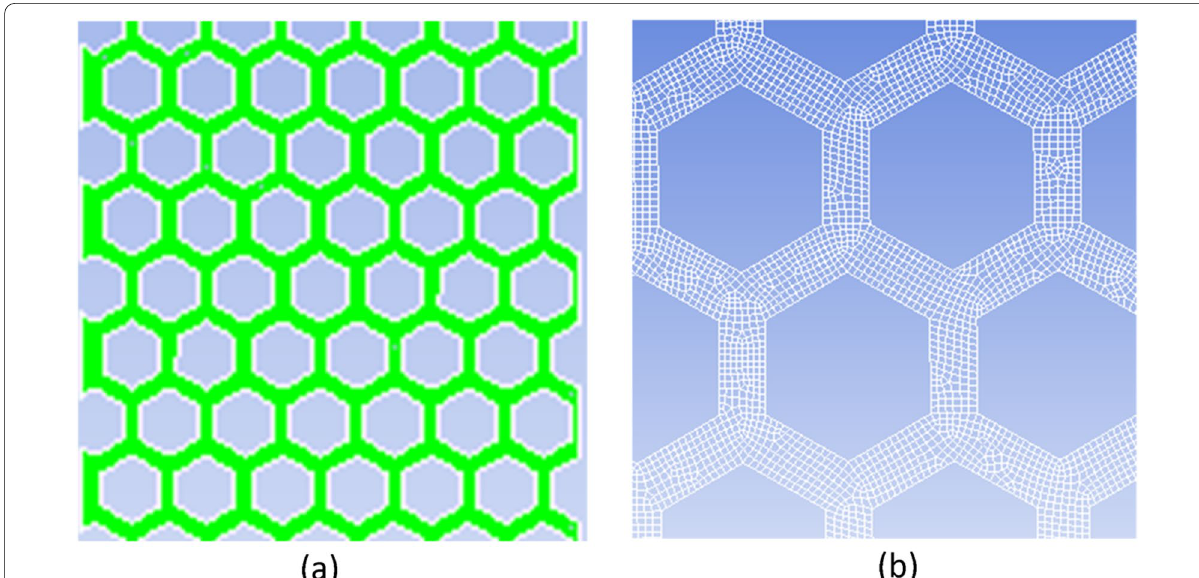
Figure 12 a FE model, and b fine mesh of the micro-channels